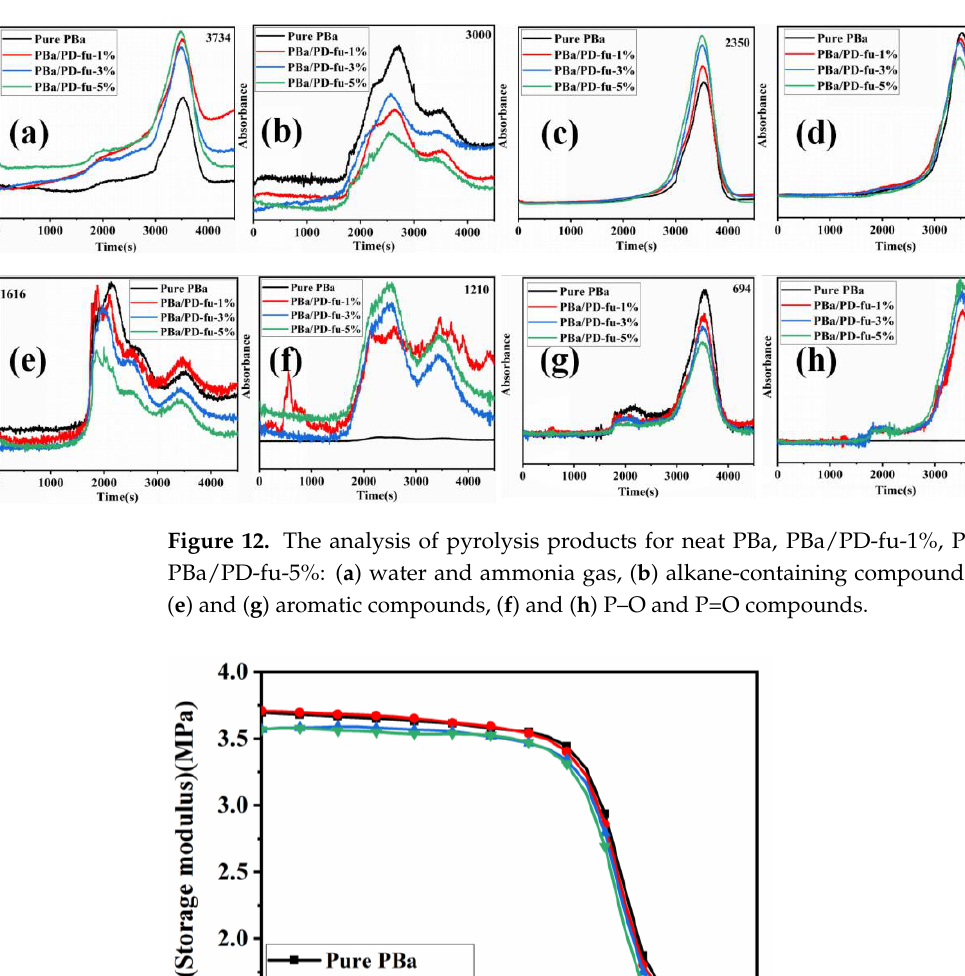
Figure 11. FTIR spectra of ( a ) PBa, ( b ) PBa/PD−fu−1%, ( c ) PBa/PD−fu−3% and ( d ) PBa/PD−fu−5% at various temperatures.